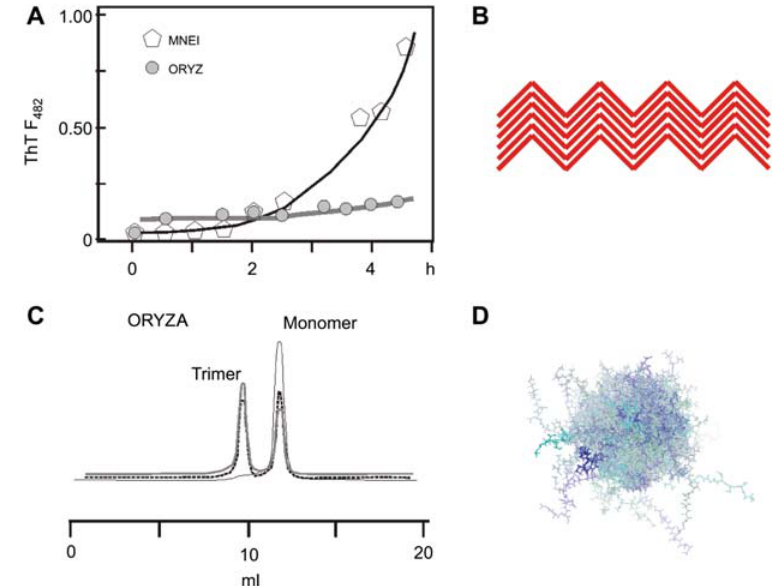
Figure 5 Modes of aggregation of MNEI and ORYZ. (A) Time dependence of ThT fluorescence emission during protein incubation: MNEI (open polygon) and ORYZ (grey circles). (B) Sketch depicting an idealized cross- b aggregate. (C) Gel filtration analysis of ORYZ, incubated at 50 8 C. Solid line indicates the elution of unheated protein, the dotted black line indicates the elution of protein incubated for 3 h and grey line indicates the elution of protein incubated for 6 h. (D) Hypothetical amorphous